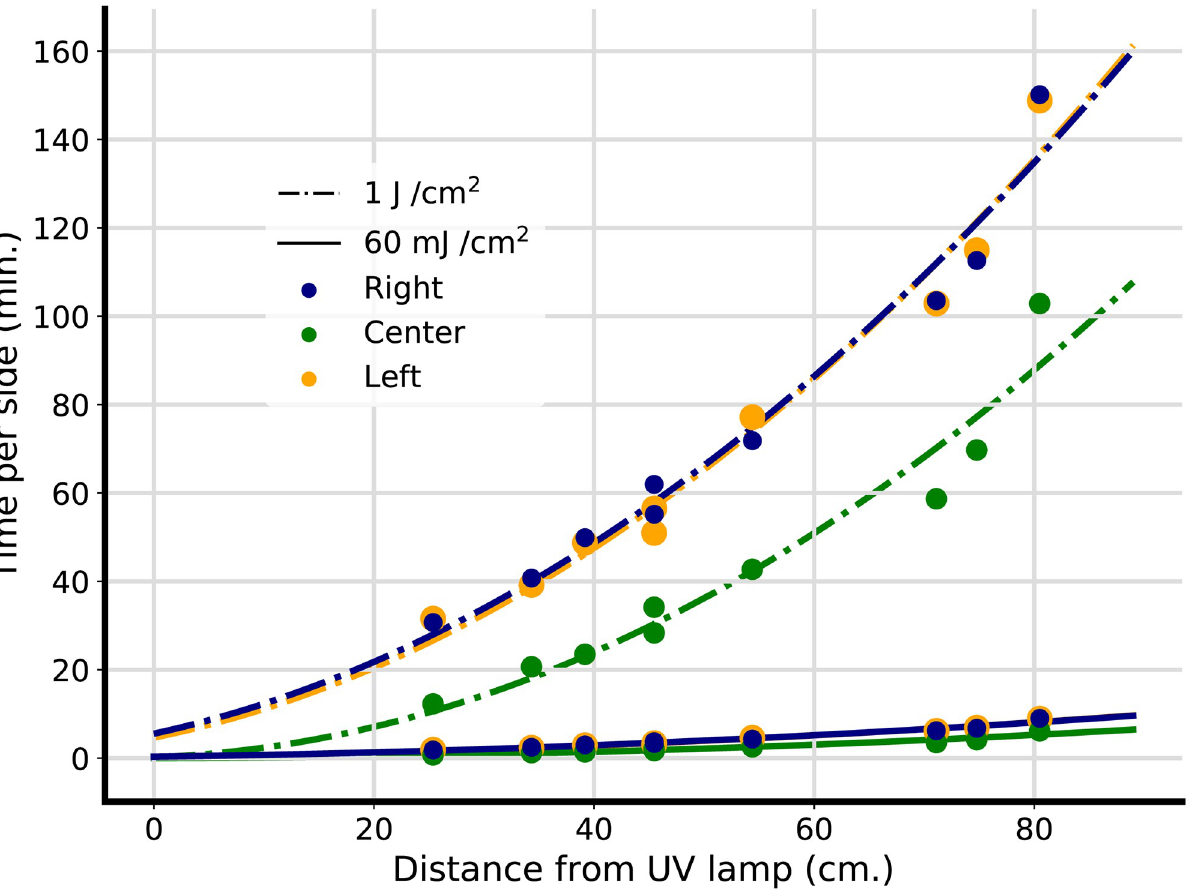
Fig 3. Time to decontaminating dose with respect to distance from UV lamp for face-shield and FFR decontaminating doses. An inverse square function was fit to UV fluence data from hood 1 at various heights for the left, center, and right-hand sections of the BSC, as visualized in Fig 2, and used to calculate time for decontaminating dose per side at target doses of 1 J cm − 2 and 60 mJ cm − 2 This approximate inverse square relation can be exploited to deliver high doses of UV within a BSC in a reasonable amount of time by positioning PPE close to the UV lamp.